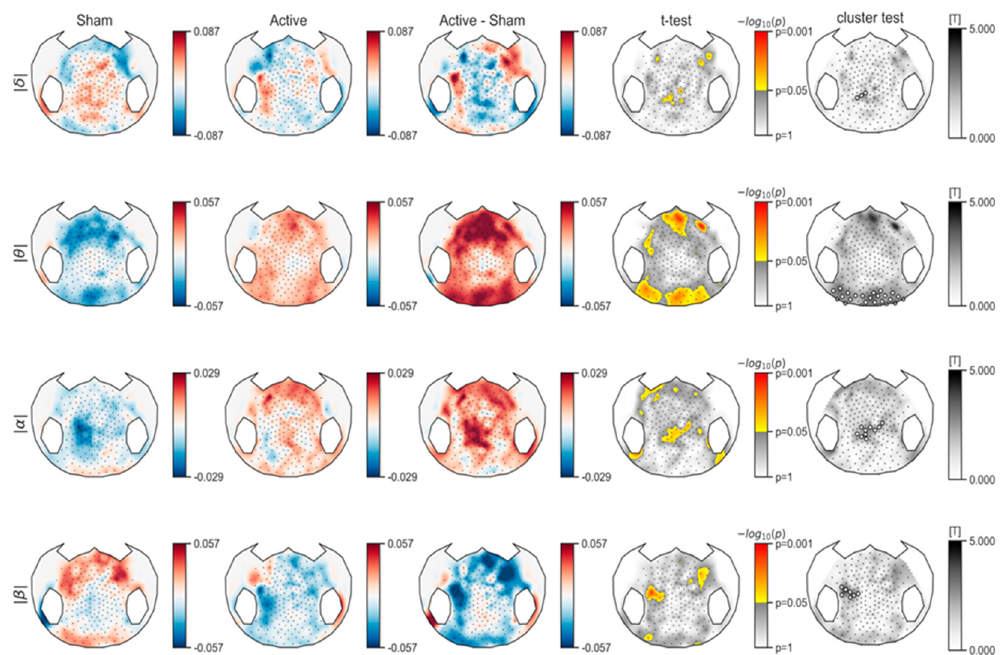
Figure 3. Relative power differences in delta, theta, alpha, and beta bands in sham and active sessions as well as for active session compared to sham session. Uncorrected related t -test results are shown for a significance level of 0.05. In the permutation cluster test results, white circles show the electrodes of the clusters found in the test. Significant clusters are shown in red (no significant cluster in this figure).